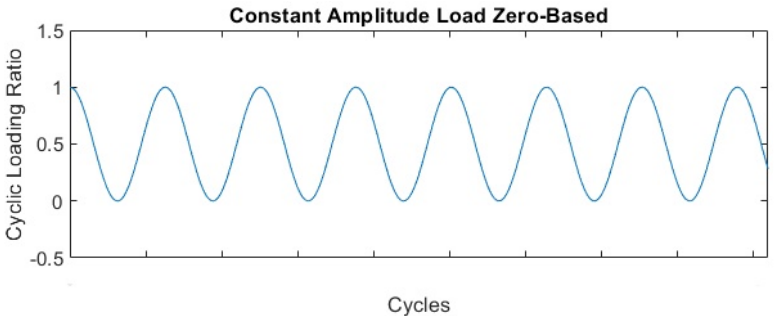
Figure 3. Constant amplitude load zero-based stress cycle.